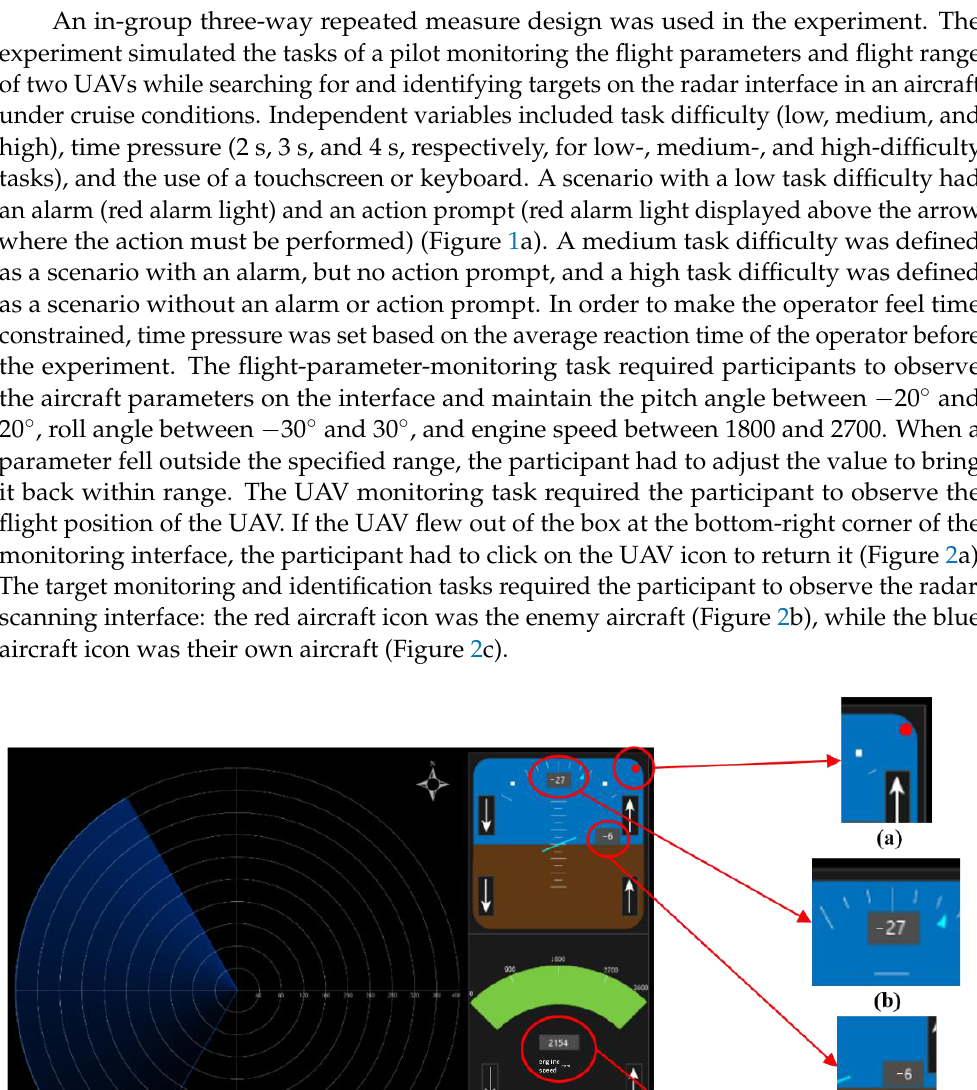
Figure 2. Simulated radar-scanning interface and UAV monitoring interface with ( a ) the appearance of enemy aircraft, ( b ) appearance of our own aircraft, and ( c ) UAV flying out of the designated box range. 2.3. Procedures Before the experiment, each participant was given a written informed consent form and a demographic information form, which they signed after learning about the experi- mental procedure. The experiment consisted of two phases: a 5 min practice phase and a 12 trial test phase (with/without time pressure  with/without a touchscreen  with three task difficulty levels). Each experimental phase lasted 10 min. The participants in each experiment were asked to observe the simulated parameter display interface. The radar sweep area was on the left, while the pitch, roll, and engine speed parameters were dis- played and adjusted from top to bottom on the right. The participants were asked to mon- itor the above parameters and keep them within the normal range, and to adjust them by clicking on the corresponding marks on the screen with the mouse (for non-touchscreen experimental conditions) or a finger (for touchscreen experimental conditions). Parame- ters that exceeded the normal range had to be adjusted downward, while those that fell below the normal range had to be adjusted upward. The participants also observed the